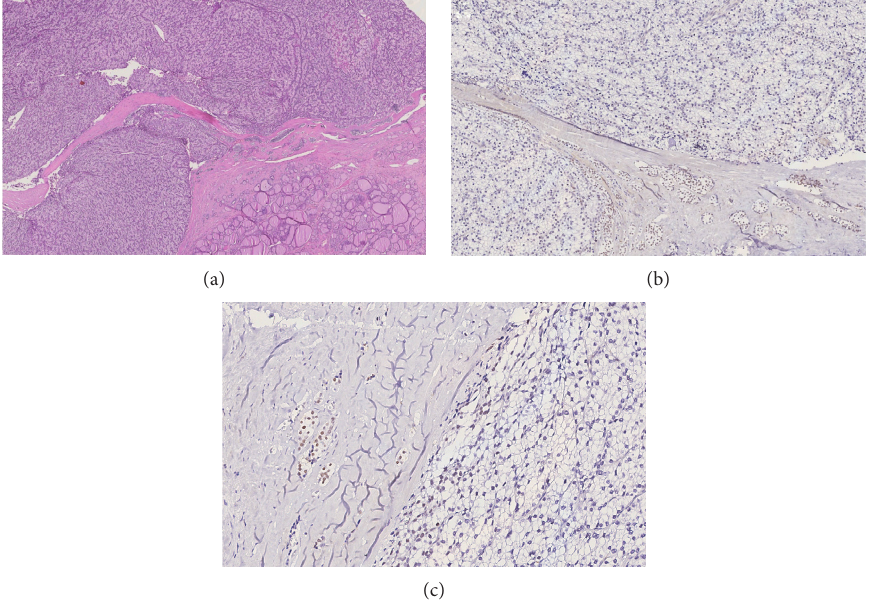
Figure 2: (a) Parathyroid adenoma: on hematoxylin-eosin tissue sections, the pushing growth pattern of the tumor and the strict adherence to thyroid tissue is observed. (b). Reduction of nuclear immunoreactivity of menin protein was observed in the neoplastic cell. (c). High- power view (X30) highlights decreased menin expression in neoplastic cells, whereas entrapped parathyroid normal cells maintain strong nuclear menin immunoreactivity. Table 1: Clinical features of the three subjects reported in the literature with MEN1 syndrome and AA. Sex Age Ca a PTH b Parathyroid Nephrolythiasis